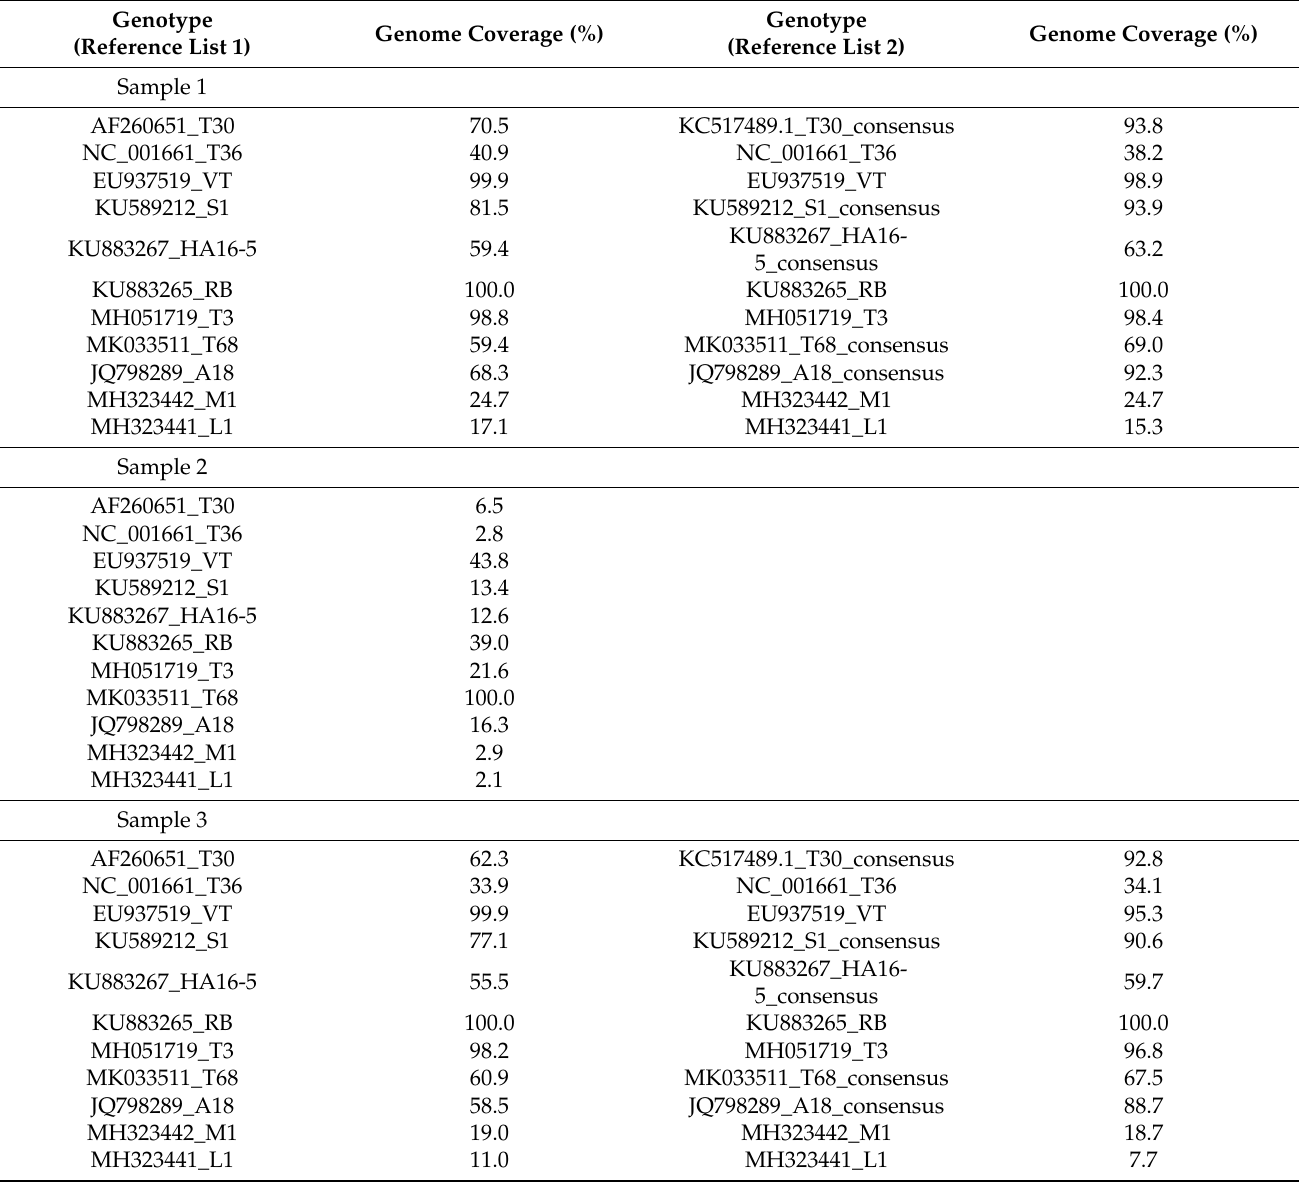
Table 3. Genome coverage (%) obtained per genotype after read mapping the real HTS data of the three samples to reference list 1 (one representative genome of each genotype) and reference list 2 (one representative genome of each genotype with the T30, S1, HA16-5, T68 and A18 genomes replaced with read mapping consensus